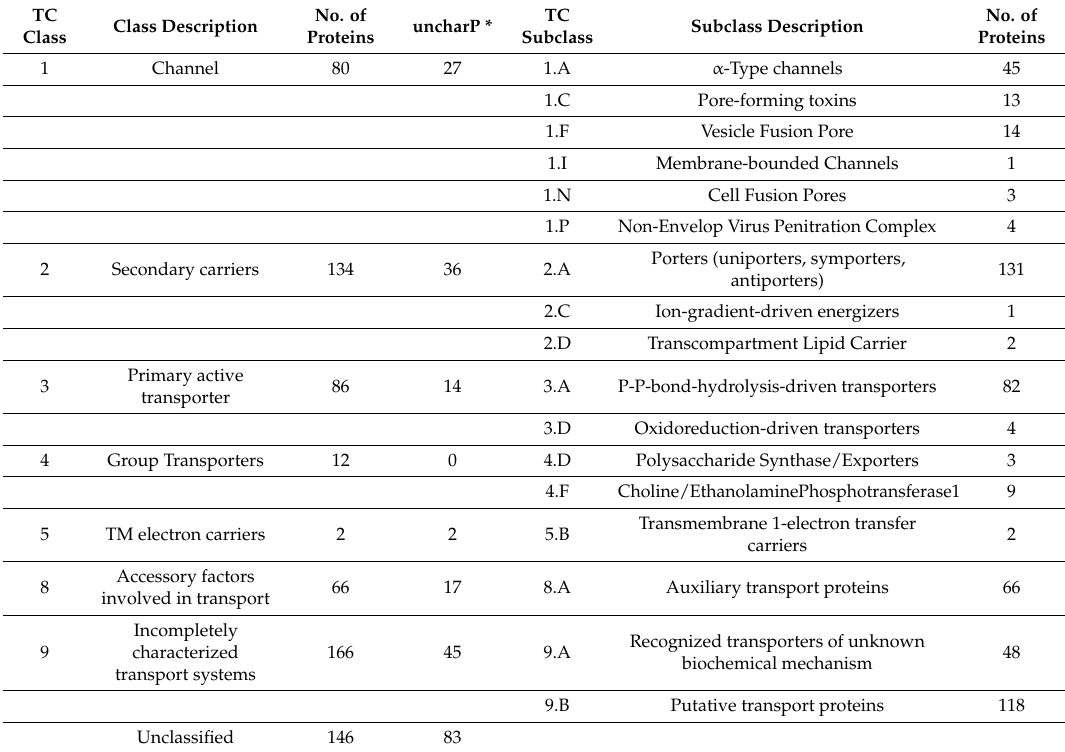
Table 2. Distribution of the TM transporters based on the transporter classification database into class and subclass in E. histolytica